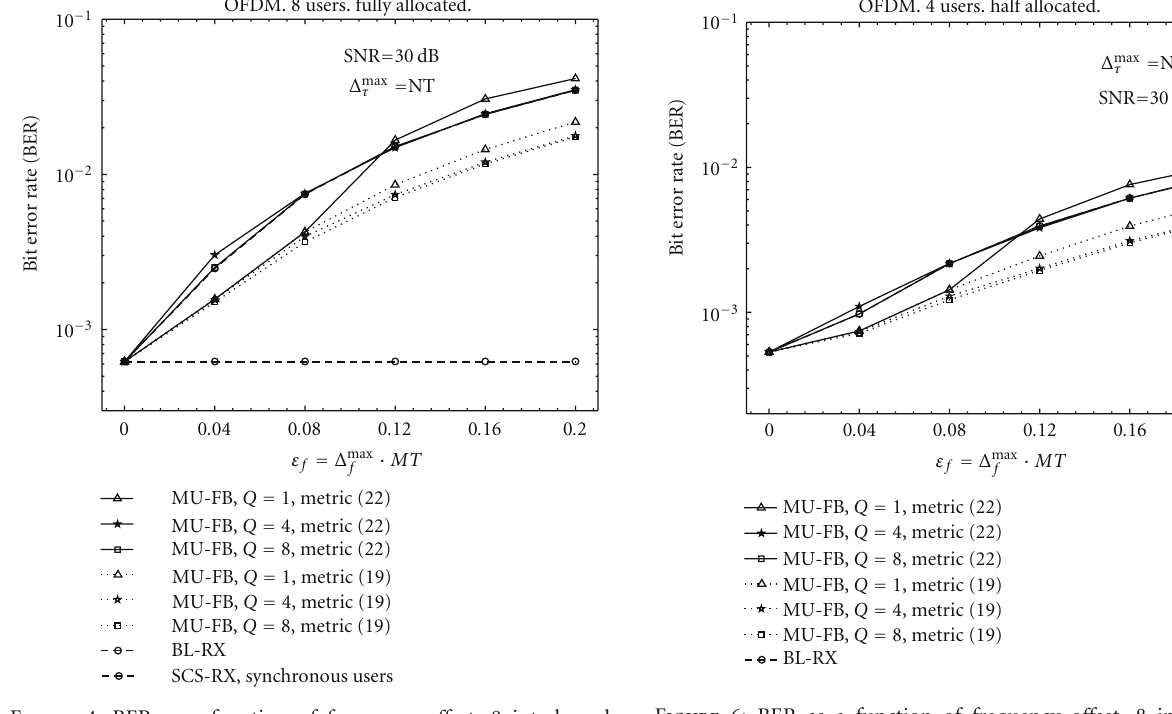
Figure 4: BER as a function of frequency o ff set. 8 interleaved users fully allocated. Comparison of the compensation metrics for di ff erent values of Q. OFDM with M = 32 and CP = 8 .